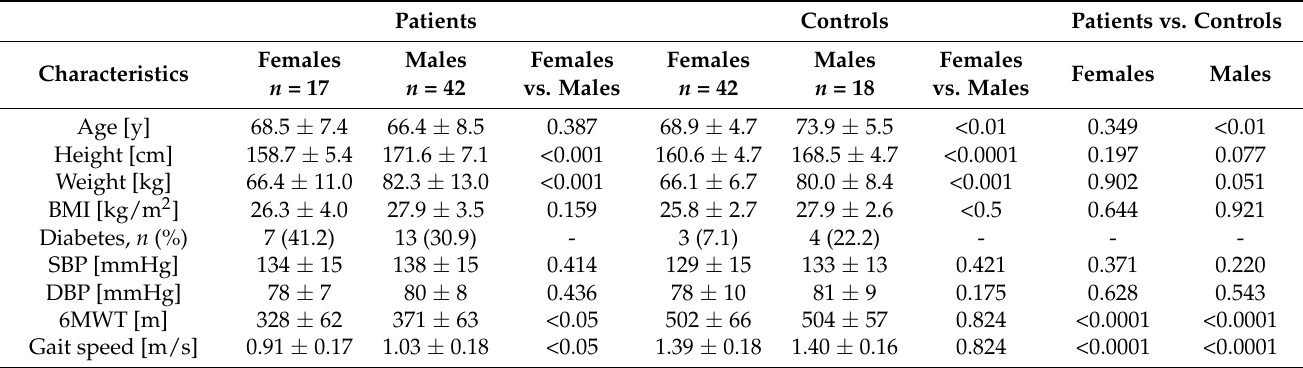
Table 1. Characteristics of the patients (mean ± SD). Patients Controls Patients vs. Controls